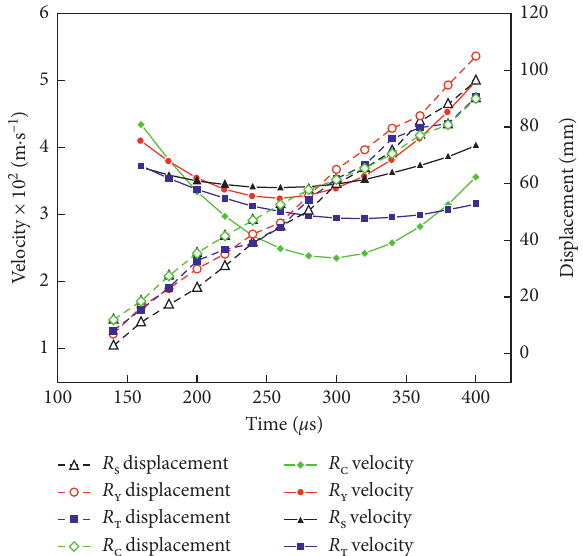
Figure 5: Explosion diffraction shock wave displacement velocity versus time